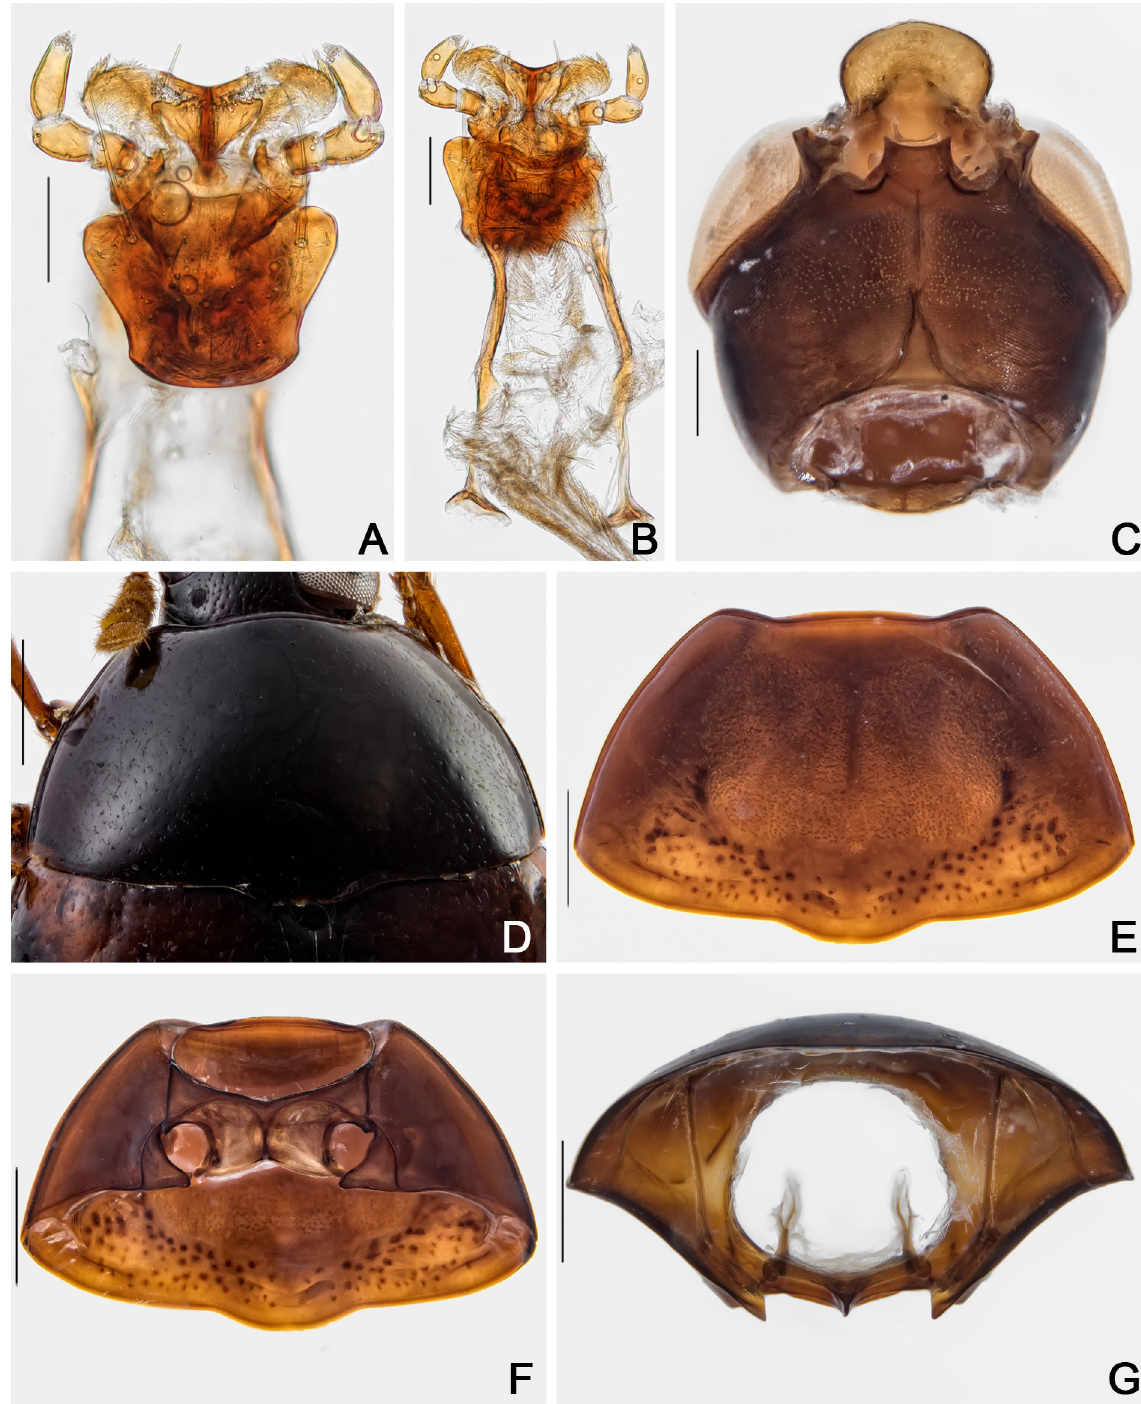
Fig. 40. Cyparium pici sp. nov. A–C . Paratype, ♂ (CELC). A . Labium. B . Hypopharynx. C . Head, ventral view. D . Holotype, ♂ (CEMT), pronotum, dorsal view. E . Paratype, ♂ (CEMT), pronotum, dorsal view. F–G . Paratype, ♂ (CELC), prothorax. F . Ventral view. G . Inner view. Specimens collected at Cotriguaçu (MT, Brazil). Scale bars: A–B = 0.1 mm; C = 0.2 mm; D–G = 0.5